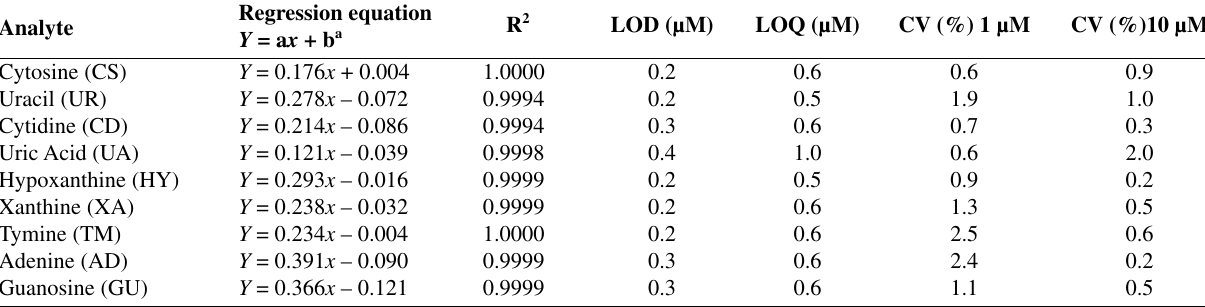
Table 2. Linear regression data (correlation coefficient R 2 , limit of detection LOD (μM), limit of quantitation LOQ (μM), and coefficient of varia- tion CV (%)) of nine investigated nucleobases in the range between 1 and 50 μM; sample volume was 20 μL.